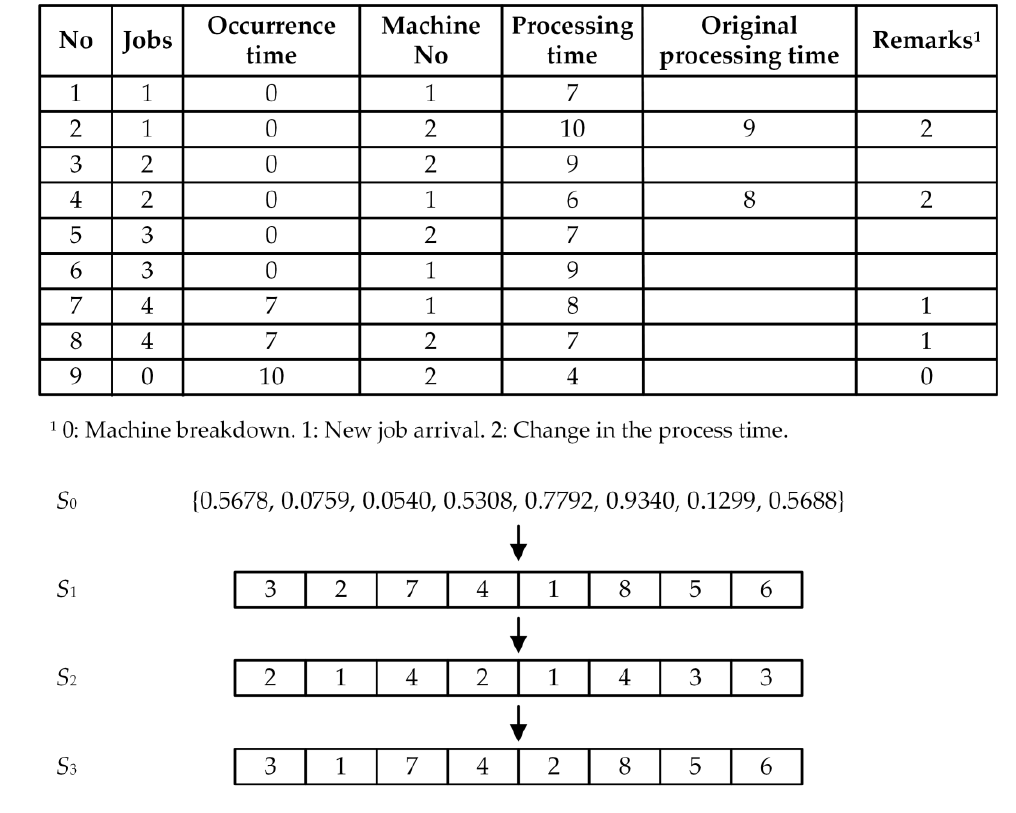
Figure 5. The instance of the solution encoding. Table 1. The benchmark instances of